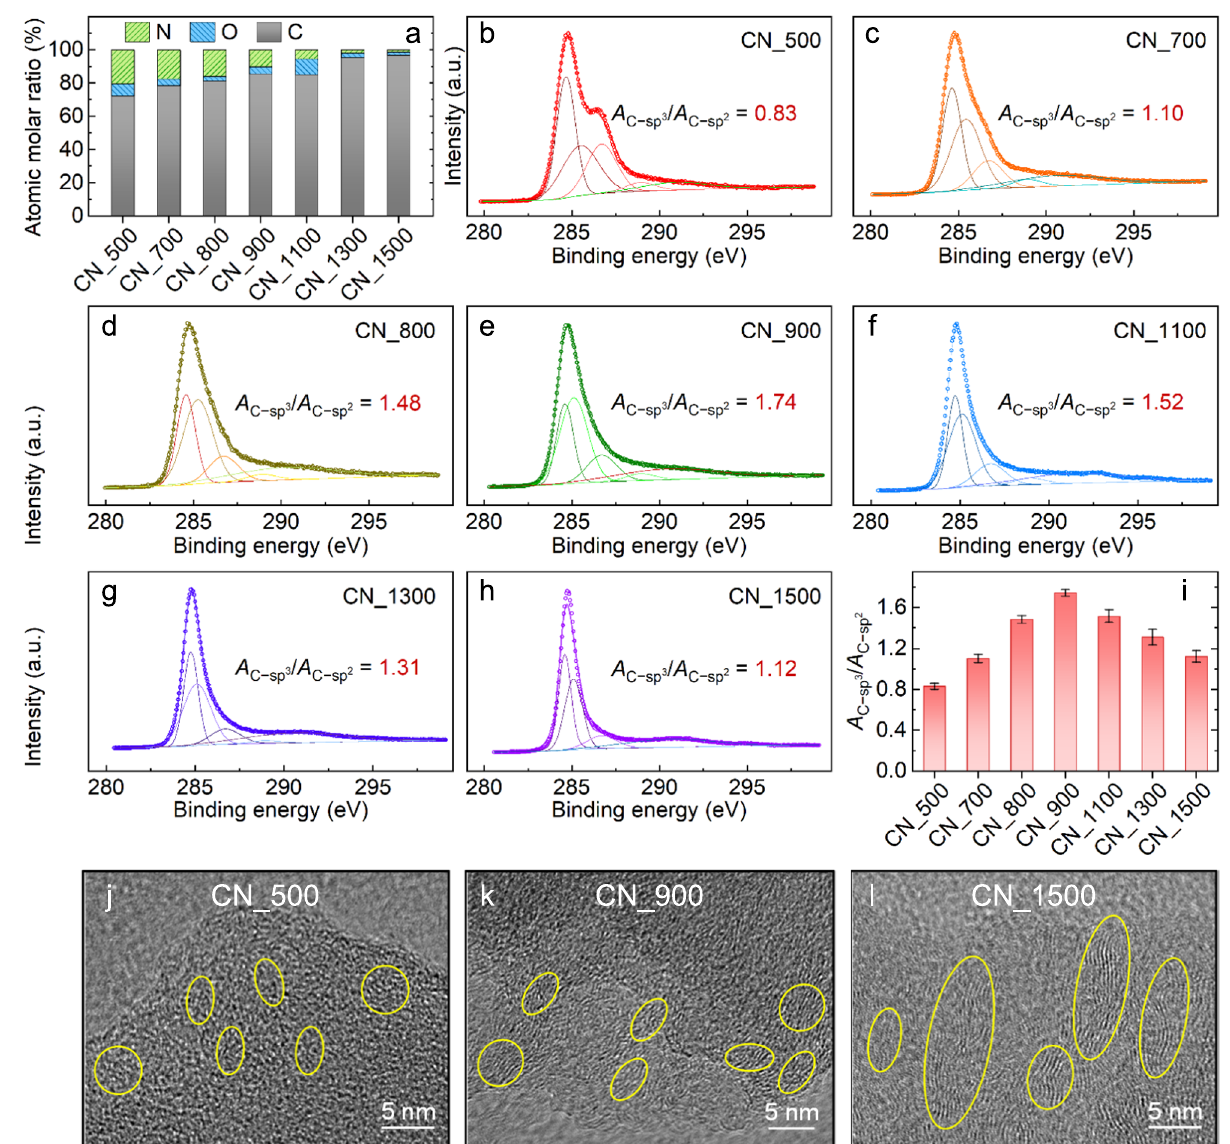
Fig. 2 | Revealing the variation of elemental constitution and carbon-based lattice. a Comparison of the overall sur fi cial elemental composition (by XPS) amongthedifferentCNs.High-resolutionC1 s XPSspectraand fi ttedpeakcurvesof the b CN_500, c CN_700, d CN_800, e CN_900, f CN_1100, g CN_1300, and h CN_1500. i Comparisonof thecalculated A C − sp3 / A C − sp2 ratiosamongthedifferent